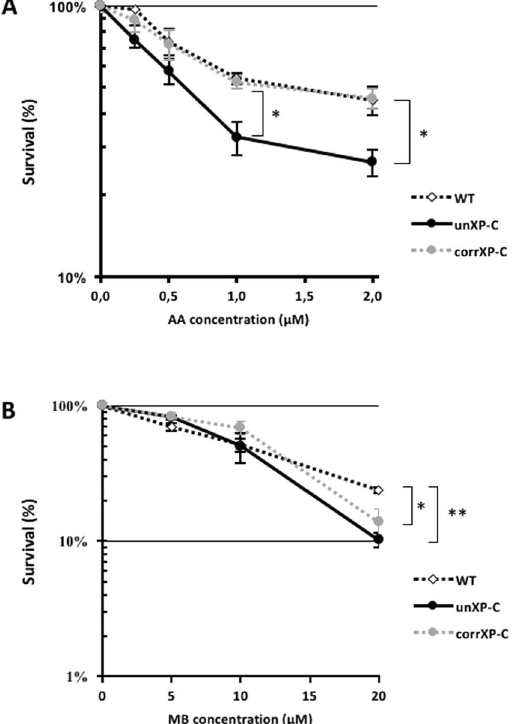
Figure 8. Absence of XPC sensitizes cells to AA and MB-induced cell death. Survival rates of cells treated with ( A ) antimycin A for 4 h or with ( B ) methylene blue subjected to photoactivation during 30 min. After treatments, individual cells were seeded at 500 cells/plate and allowed to grow to visible colonies. Survival was calculated relative to the plating efficiency of untreated cells. Values represent the mean ± s.e.m. of 4 independent experiments. * p < 0.05 and ** p <